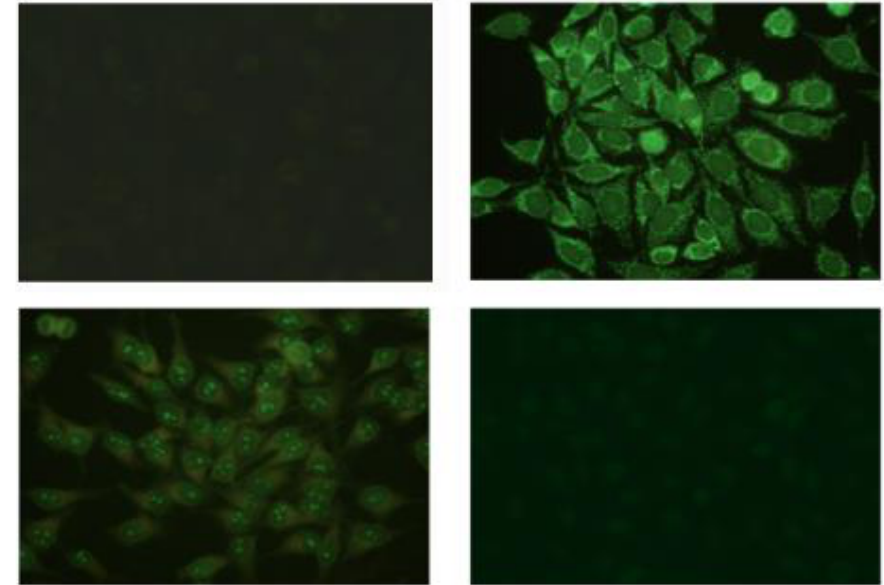
Figure 1. Examples of indirect immunofluorescence (IIF) images with different fluorescence intensity: in the upper left a positive centrioles image, in the upper right a positive cytoplasmic image, in the lower left a positive nucleolar image, in the lower right a negative image. The positivity/negativity of fluorescence is not strictly correlated with the luminous intensity of the Human Epithelial type 2 (HEp-2) images; the image in the upper left for example, although presenting low light intensity, has a positive fluorescence intensity.